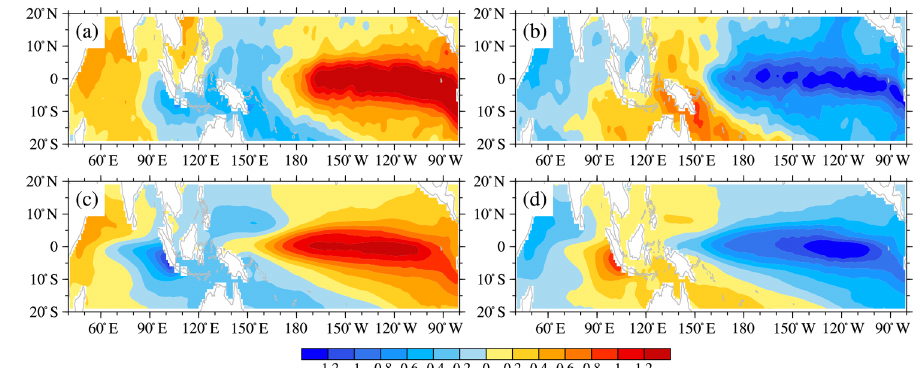
Figure 10. The tropical Pacific–Indian Ocean SSTAs of the PIOAM positive (a, c) and negative (b, d) phase in October in the HadISST dataset (a, b) and the MME of CMIP5 models (c, d) (unit: ◦ C).